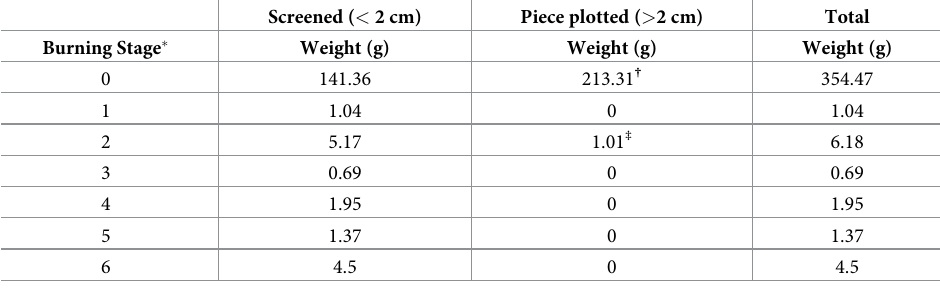
Table 2. T17 Unit 3 fauna burning